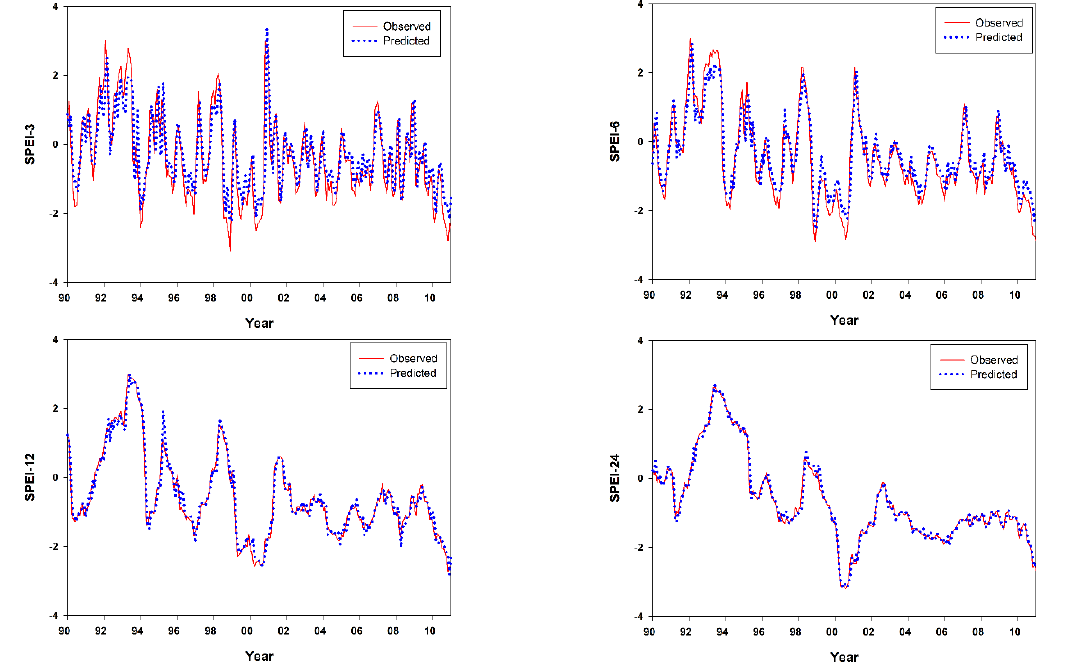
Figure 11. Observed and predicted standardized precipitation evapotranspiration index (SPEI) series over different time scales based on mean precipitation during 1990 to 2011 for Hail